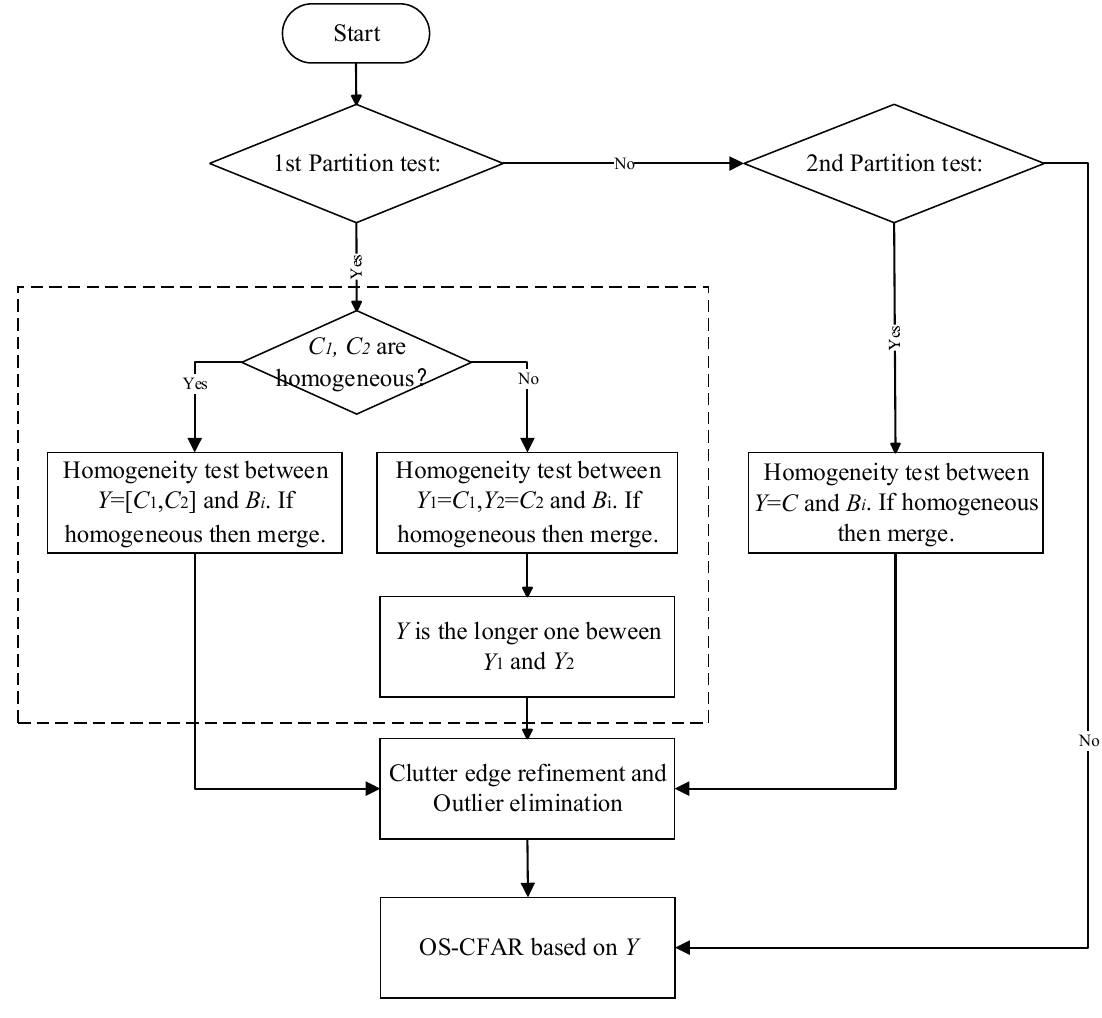
Figure 3. Flow chart of homogenous clutter block